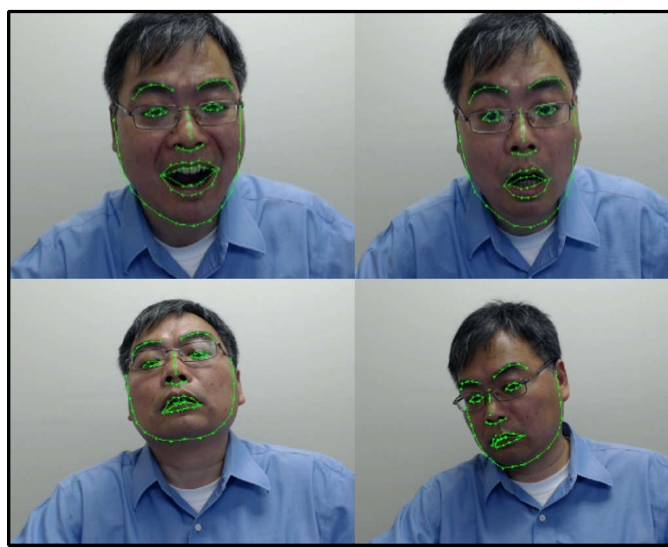
Figure 10. Facial landmark detection results based on SDM.